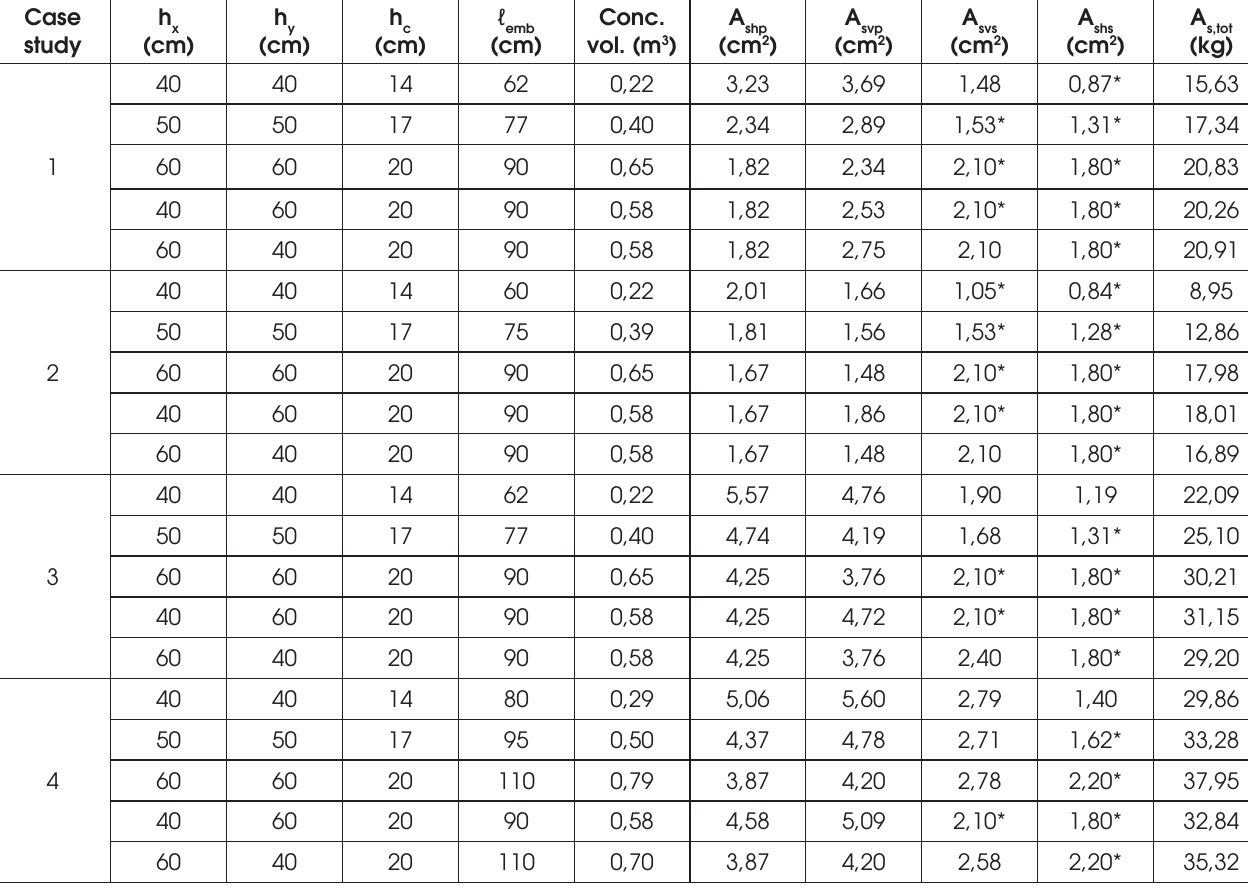
Influence of the column section on the material consumption of the socket base